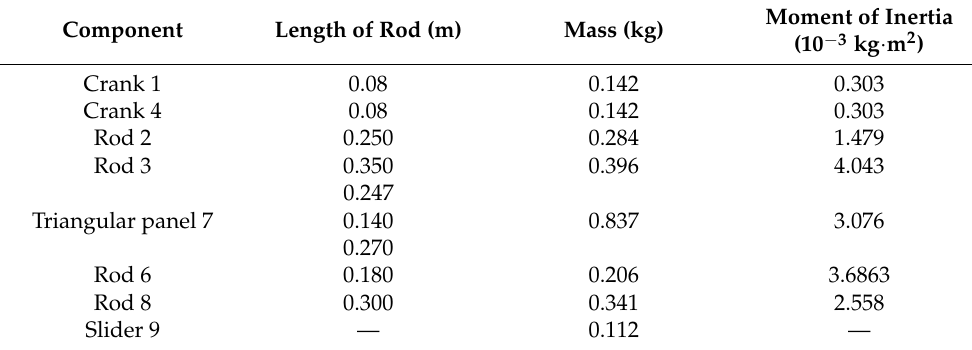
Table 4. Geometric and inertial parameters of the test platform.